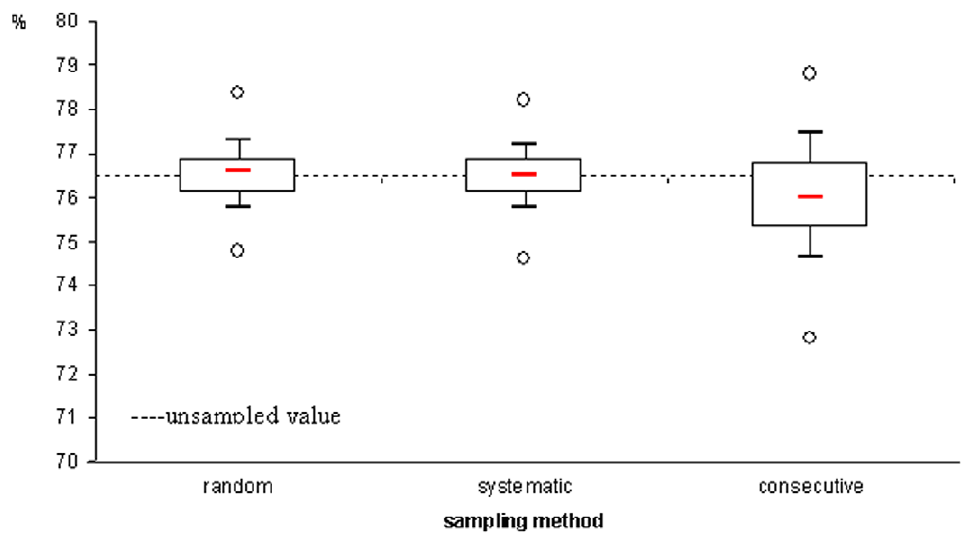
Figure 1. Proportion of patients on ART at 12 months: comparison of estimates according to the sampling technique (median, inter-quartile range, 10–90% deciles and minimum maximum) with the unsampled value (dotted line).